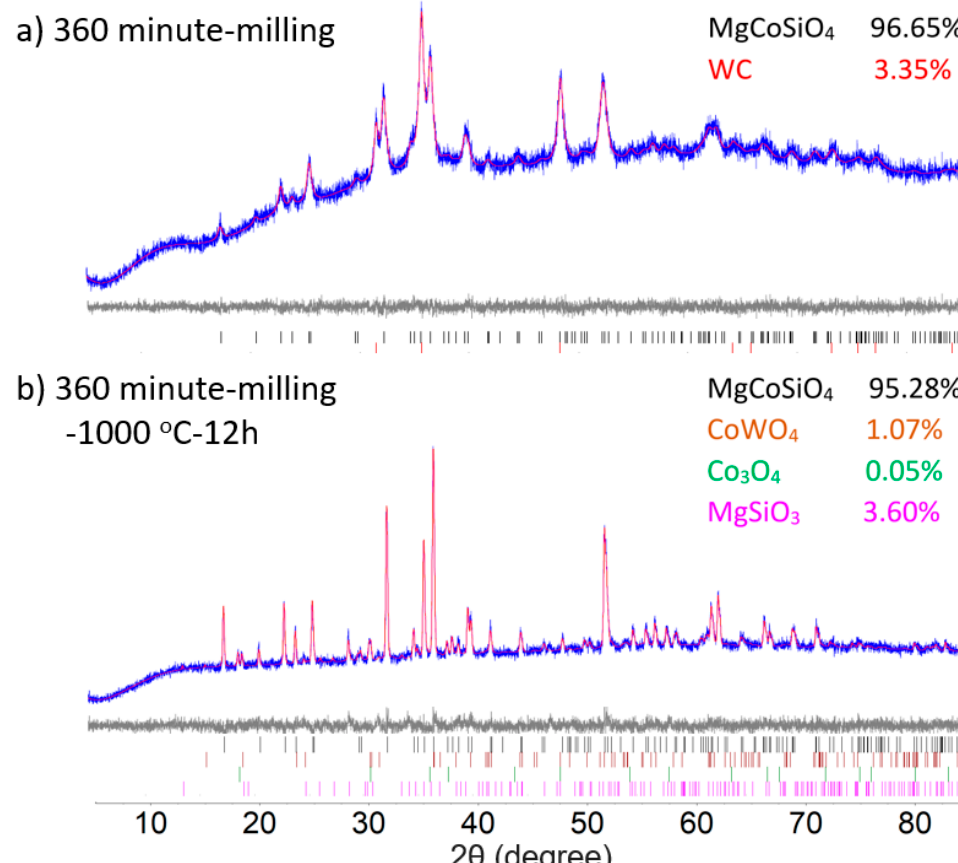
Figure 3. Rietveld refinement of the ( a ) 1:1:1 molar ratio of MgO, CoO and SiO2 after ( a ) 360 min milling time and ( b ) 360 min milled mixture followed by heating at 1000 °C for 12 h. The bottom curve shows the difference between the observed and the calculated intensities. Tick marks below indicate the peak positions for cobalt silicate and WC/CoWO 4. Table 1. Unit cell parameters obtained from the Rietveld refinement of the synthesized MgCoSiO 4, before and after heating in comparison with literature values.